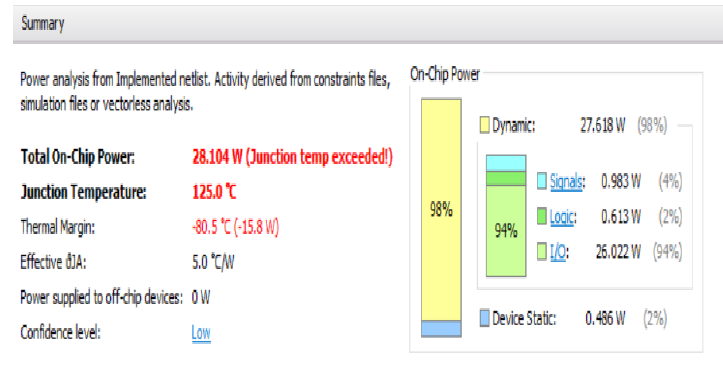
Figure 11. Trojan-inserted summary results.